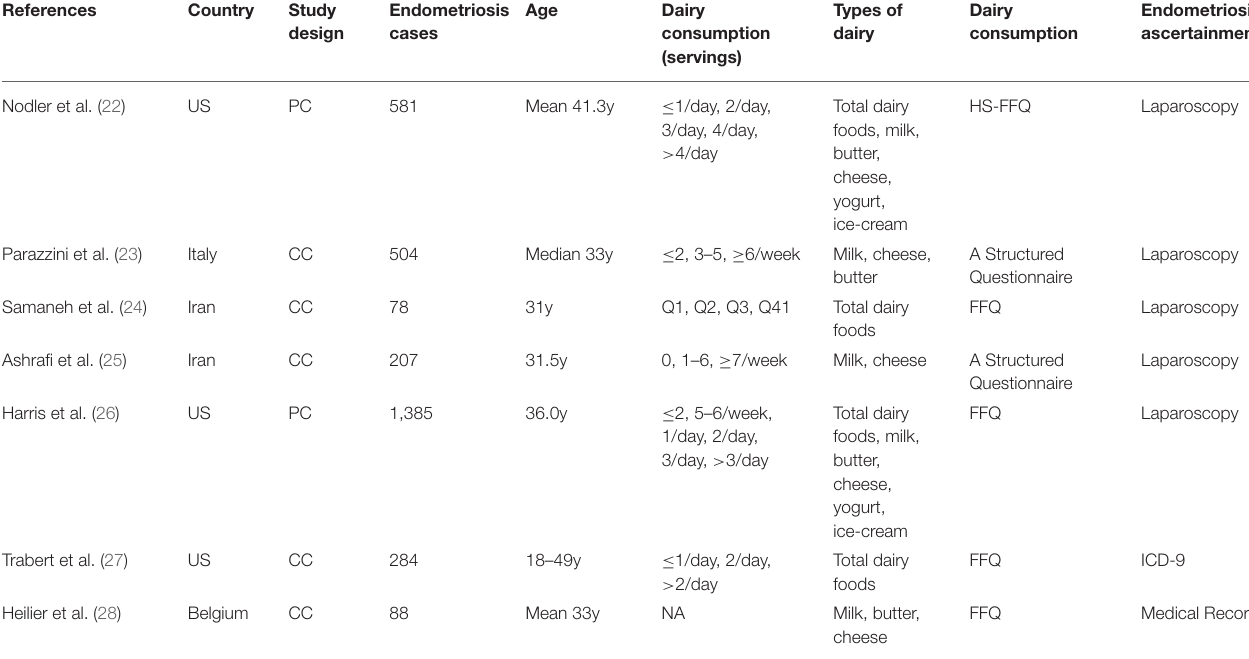
TABLE 1 | The details of the included 7 observational